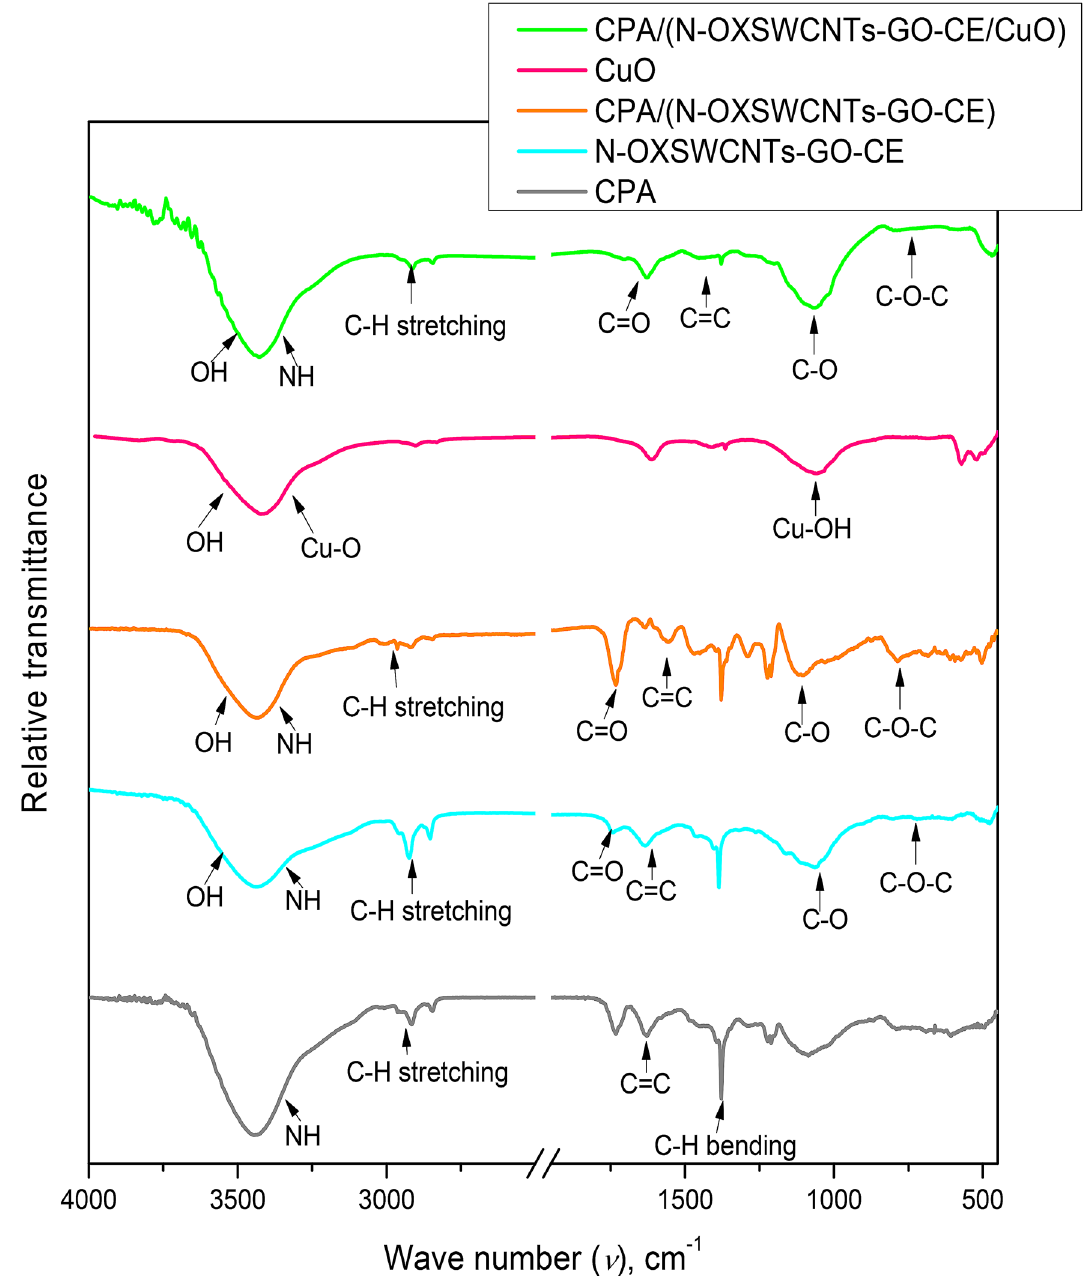
Figure 5. IR spectra for pure CPA, N-SWCNTs-GO-CE, CPA/N-SWCNTs-GO-CE, CuO, and CPA/N- SWCNTs-GO-CE/CuO